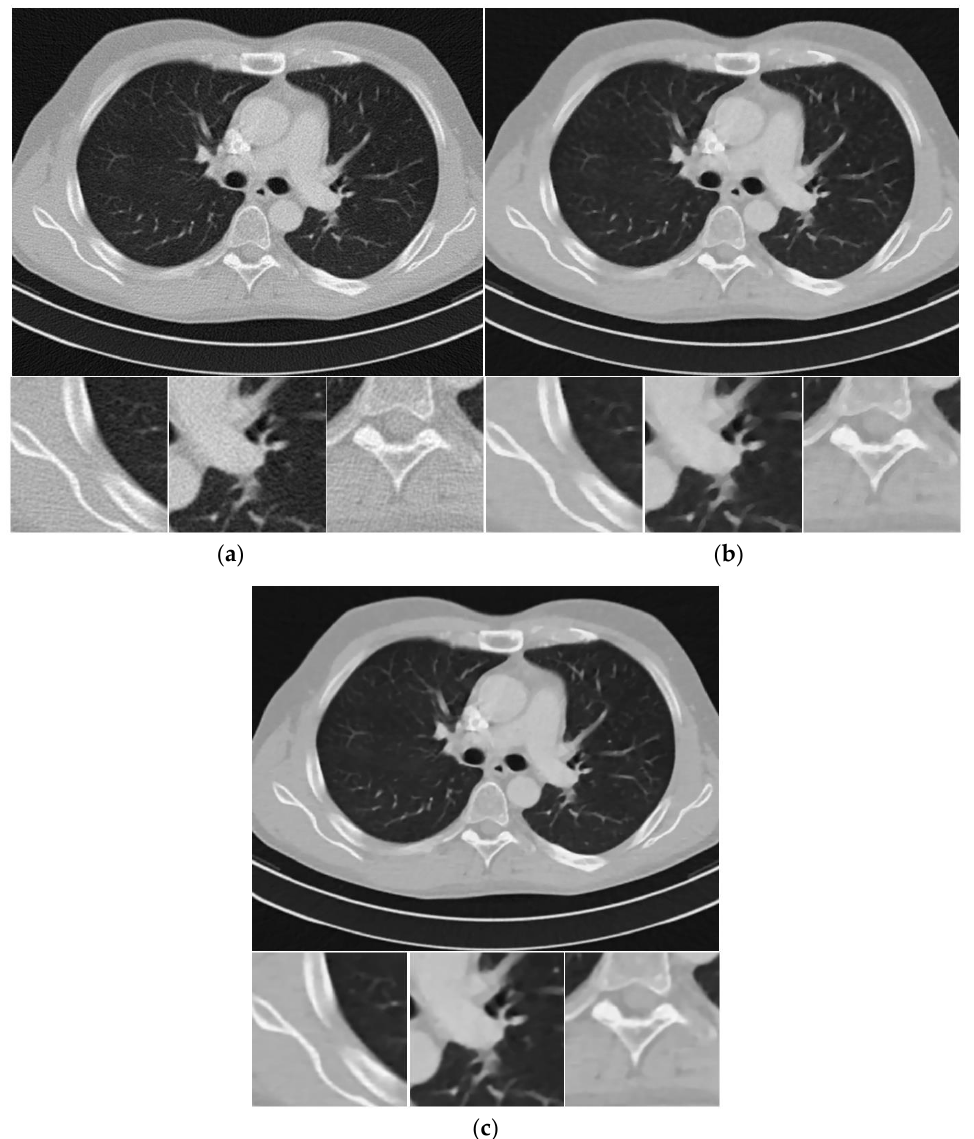
Figure 4. Thorax CT images reconstructed by ( a ) FBP, ( b ) SIR-TV, and ( c ) SIR-STV 1 methods from noisy projections with 5 × 10 4 incident photon number. The display window is [–1000, 667] HU. Table 2. A summary of the evaluation indexes of the reconstructed image at di ff erent noise levels in the Thorax image simulated